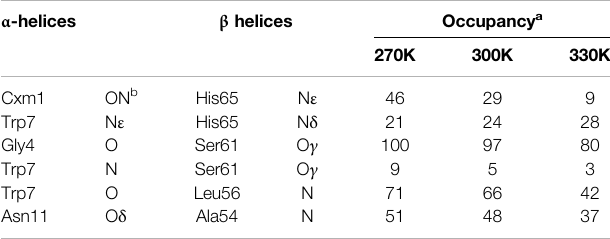
TABLE 1 | Essential intermolecular hydrogen bond occupancies between residues in α and β polypeptide helices. α